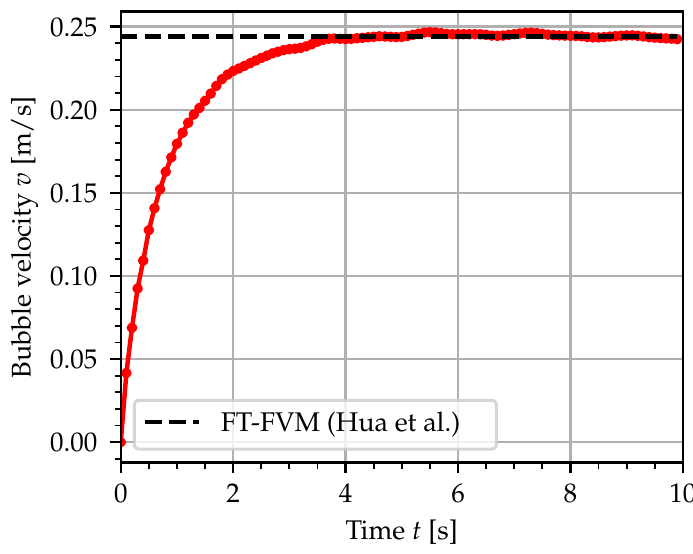
Figure 10. Bubble velocity evolution compared against the terminal velocity of [3].